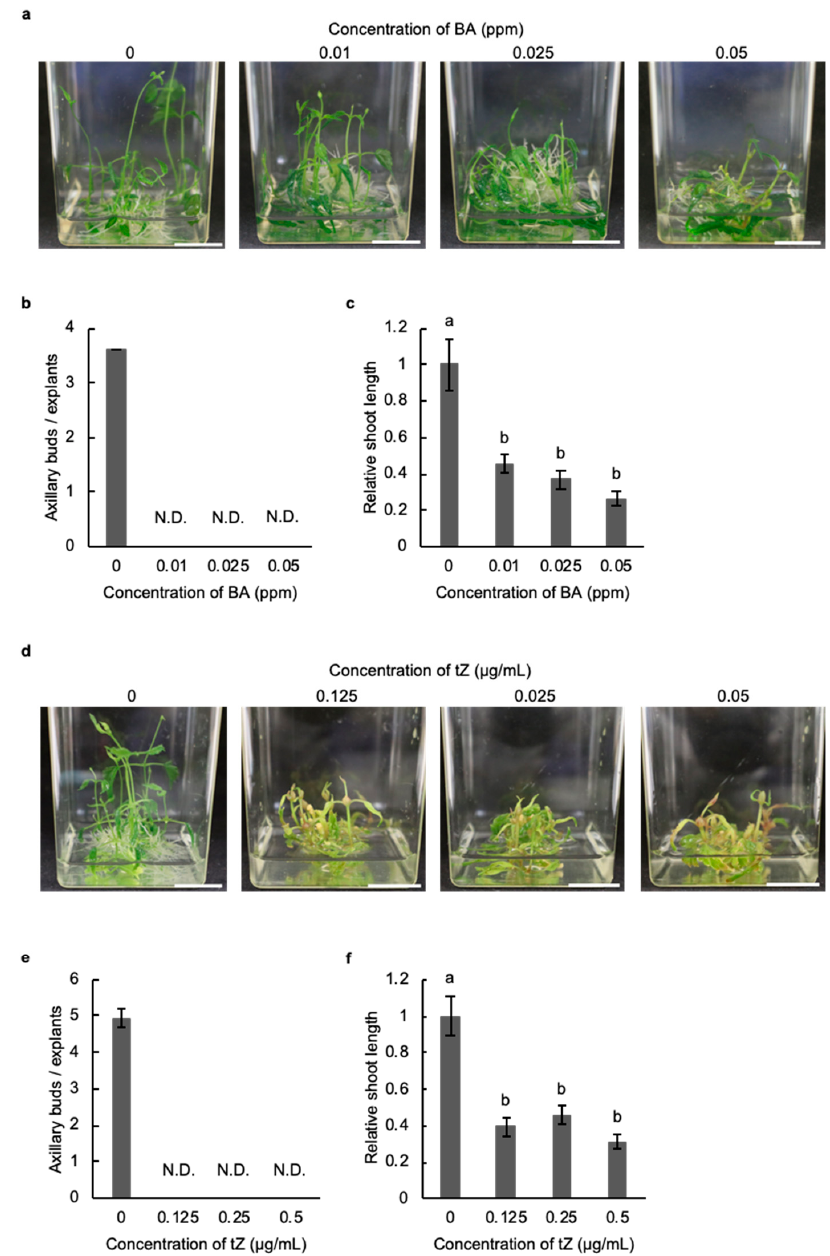
Figure 2. Cytokinin inhibits the development of axillary buds in hop. ( a ) Axillary bud development in stem explants of the hop cultivar Kirin-2 in liquid medium supplemented with benzyl adenine (BA) for 3 weeks. Scale bar: 1 cm. ( b ) The number of axillary buds in stem explants without and with BA for 3 weeks. N.D. indicates no detection ( n ≥ 15, individual experiment). ( c ) Relative shoot length in stem explants treated without and with BA for 3 weeks. The shoot length of explants treated with BA was normalized against the shoot length of explants without BA ( n ≥ 10, individual experiment, p < 0.05; Tukey–Kramer test). Different letters indicate significant differences. ( d ) Axillary bud development in stem explants of the hop cultivar Kirin-2 in liquid medium supplemented with trans -zeatin (tZ) for 3 weeks. Scale bar: 1 cm. ( e ) Number of axillary buds in stem explants without and with tZ for 3 weeks. N.D. indicates no detection ( n ≥ 15, individual experiment). ( f ) Relative shoot length of stem explants without and treated with tZ for 3 weeks. The shoot length of explants treated with tZ was normalized against the shoot length of explants without tZ ( n ≥ 10, individual experiment, p < 0.05; Tukey–Kramer test). Different letters indicate significant differences.